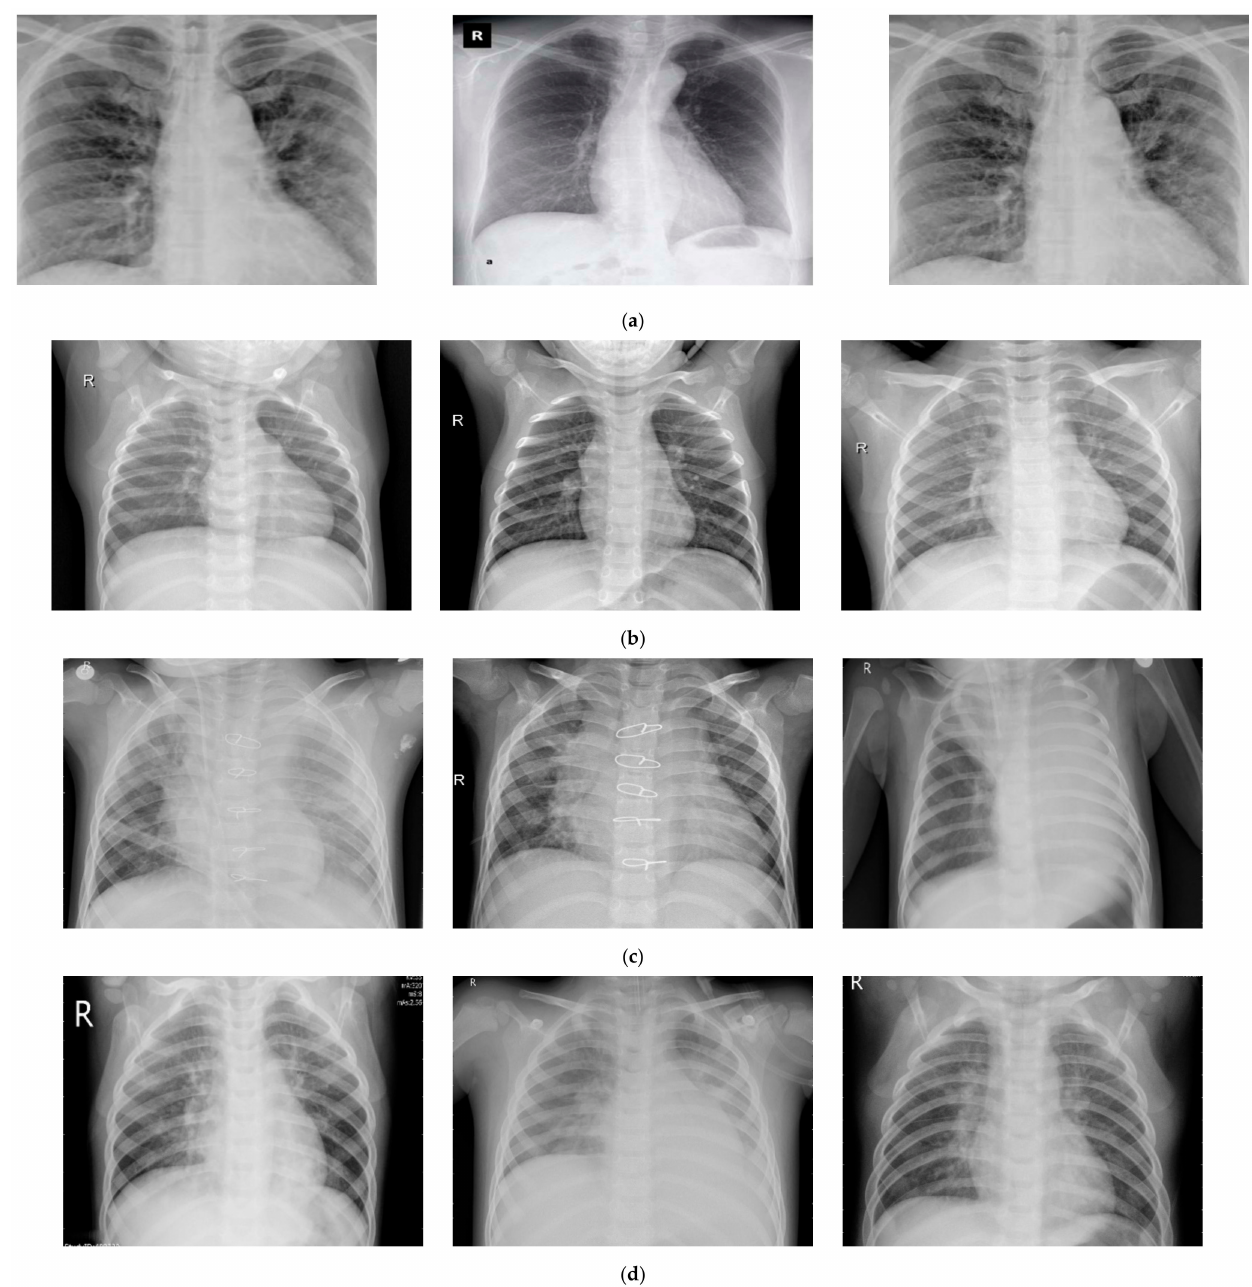
Figure 1. Sample of the collected dataset: ( a ) normal images, ( b ) bacterial pneumonia, ( c ) viral pneumonia, and ( d ) Coronavirus-infection